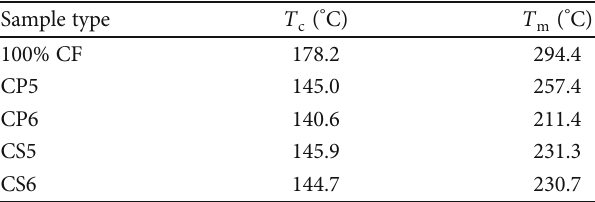
Figure 3: Thermal transitions DSC of the woven kenaf/carbon fi bre hybrid composite vs. 100% carbon fi bre epoxy composite. Table 4: DSC results of pure carbon fi bre and woven kenaf/carbon fi bre hybrid